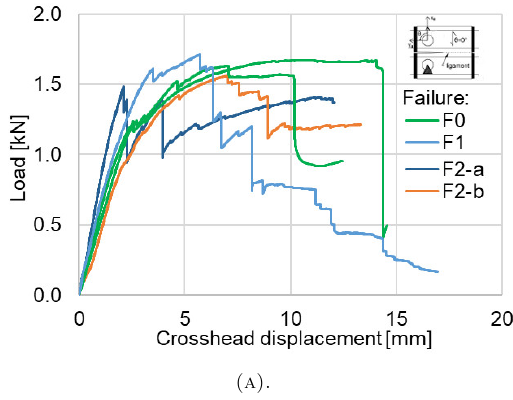
Figure 7. Load vs. crosshead displacement for pre- stressed CT specimens with the load-grain angle of θ = 0° that failed in modes F0, F1, and F2. [3] Figure 8. 2D FE mesh composed of approx. 2 . 5 mm